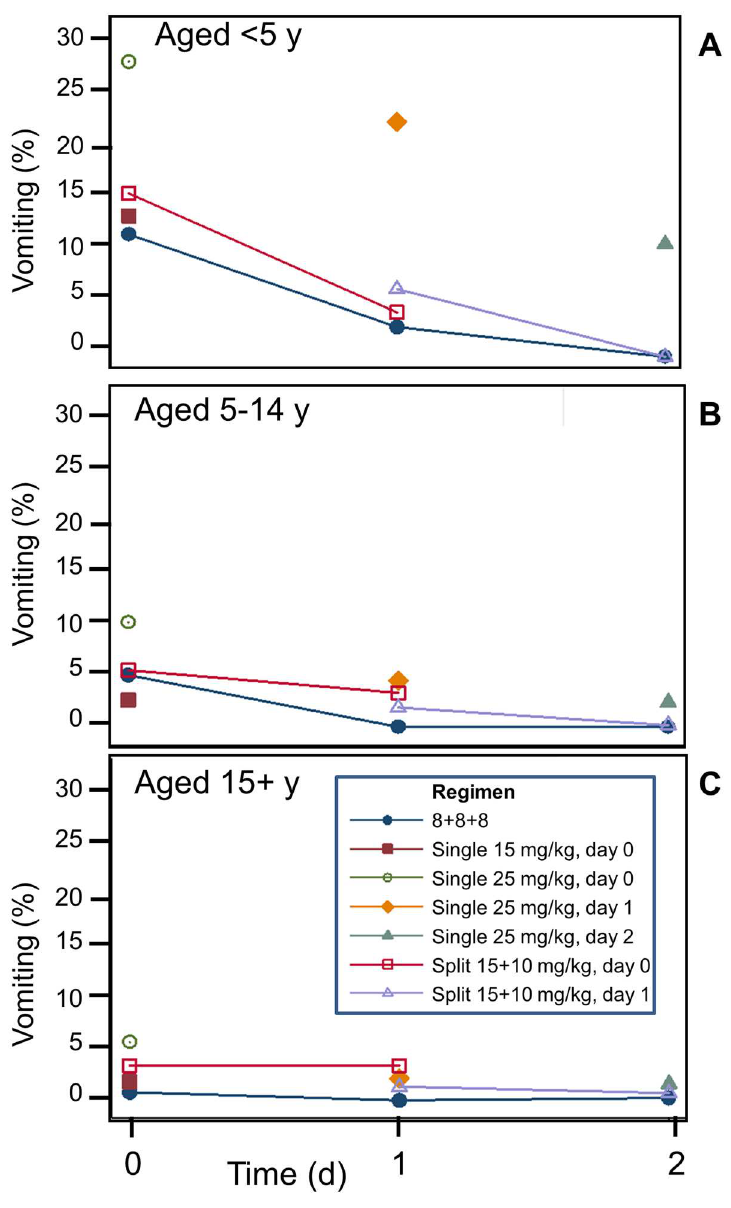
Fig 2. Vomiting frequency (by episode) directly ( < 1 h) after mefloquine (MQ) administration. Frequencies are by age group ( A-C ) and day of treatment.